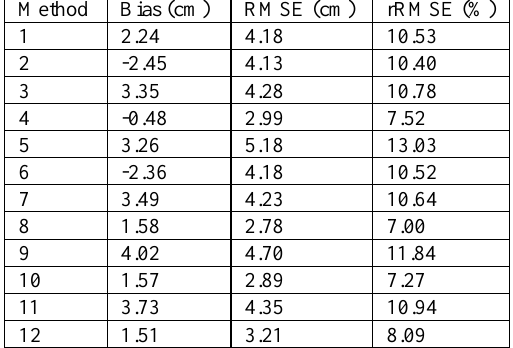
Table 3. The bias and RMSE resulting from the estimation of